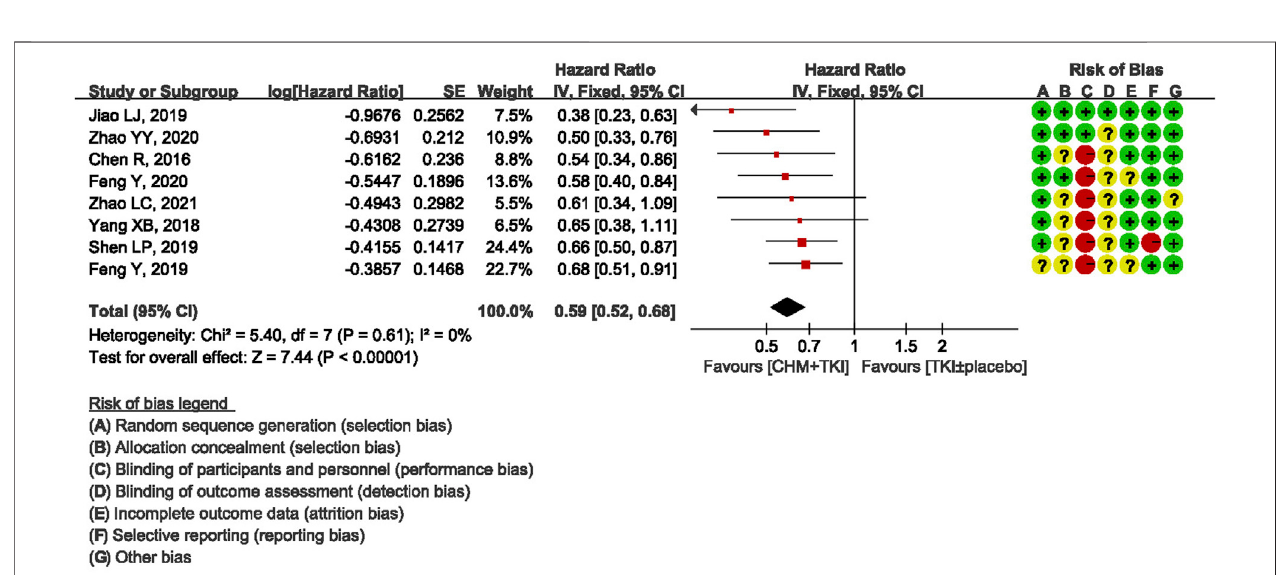
FIGURE 3 | Forest plot showing